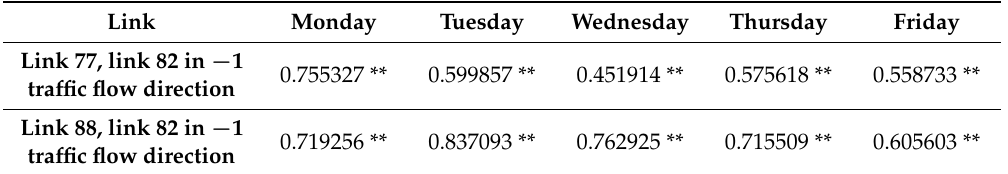
Figure 3. The correlation among link 77, link 82 and link 88. Table 1. The correlation coefficient of speed expectation in a certain direction and different time among target link 82, adjacent link 77 and adjacent link 88.